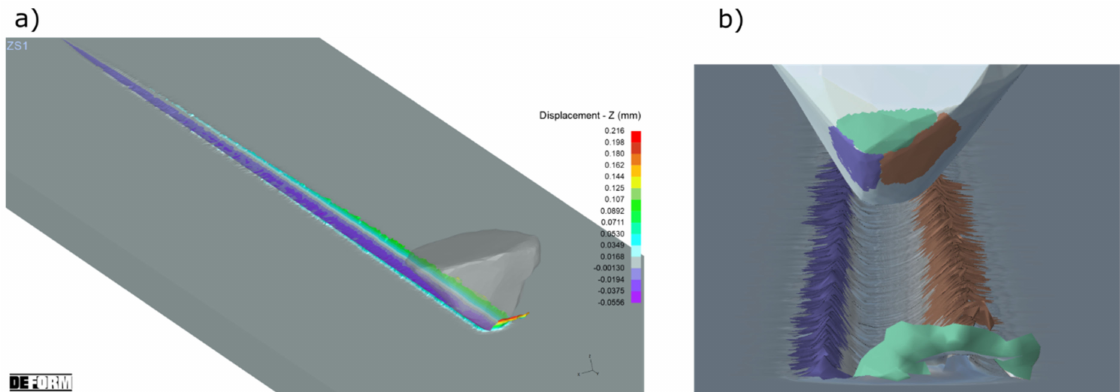
Figure 12. The results of the computer simulation of the cutting process with ZS1 grain ( a ) and the colored areas which caused the plastic flows of the processed material ( b